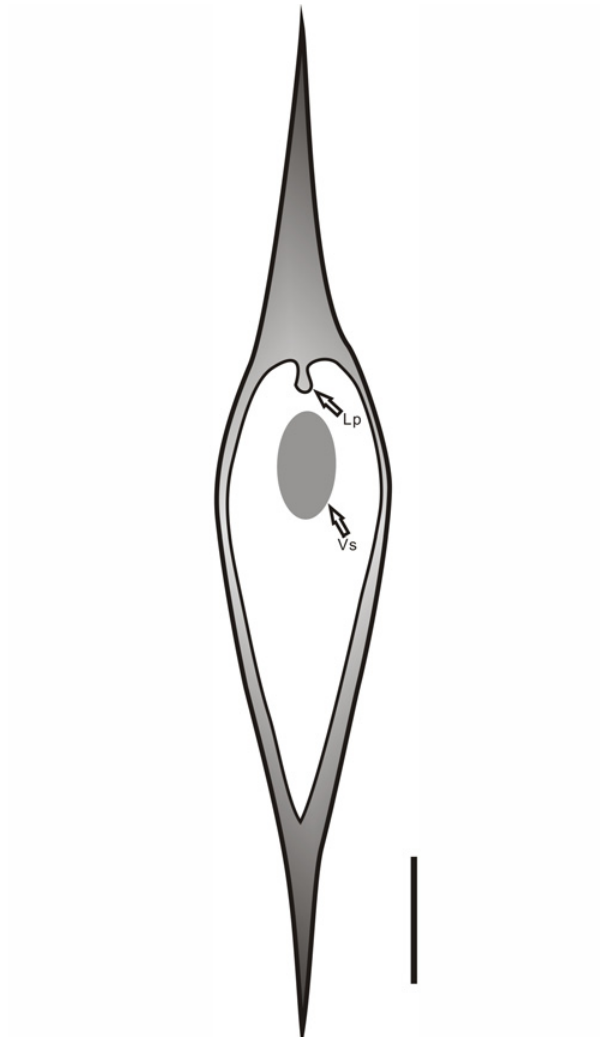
Fig 2. Diagram of the leaf cushion of Minostrobus chaohuensis . Oblanceolate leaf scar, ligule pit (Lp) and vascular scar (Vs). Scale bar = 1